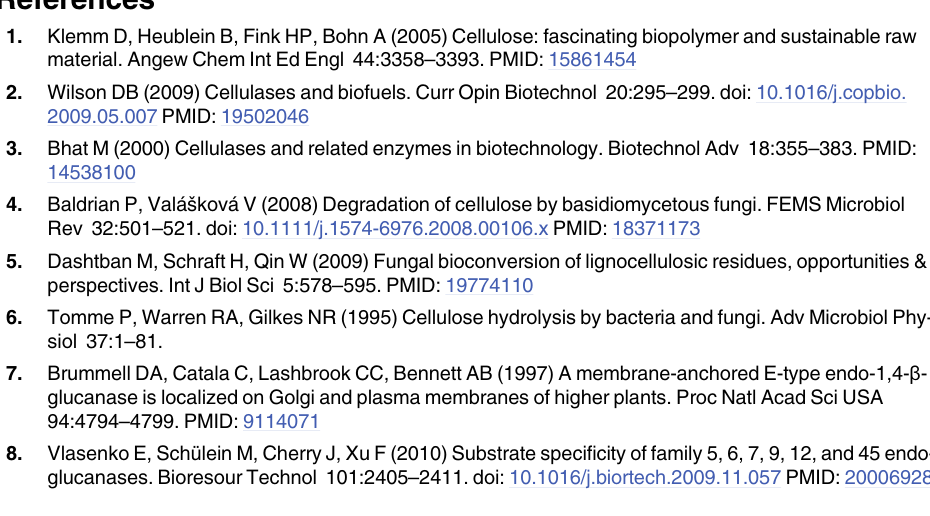
S1 Fig. Multiple alignment of the Cel7A protein sequence and homologous enzymes. S2 Fig. Time course of hydrolysis of barley β -glucan by Cel7A. S3 Fig. The nucleotide and amino acid sequence analysis of Cel7A. S1 Table. Summary of the purification of recombinant Cel7A. S2 Table. Effect of endo- β -1,4-glucanases on the viscosity and filtration rate of